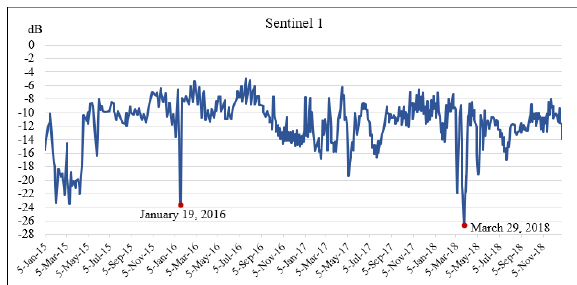
Figure 6. The calibrated Sentinel 1 Level-1 SAR time series covering the period 2015 – 2018.